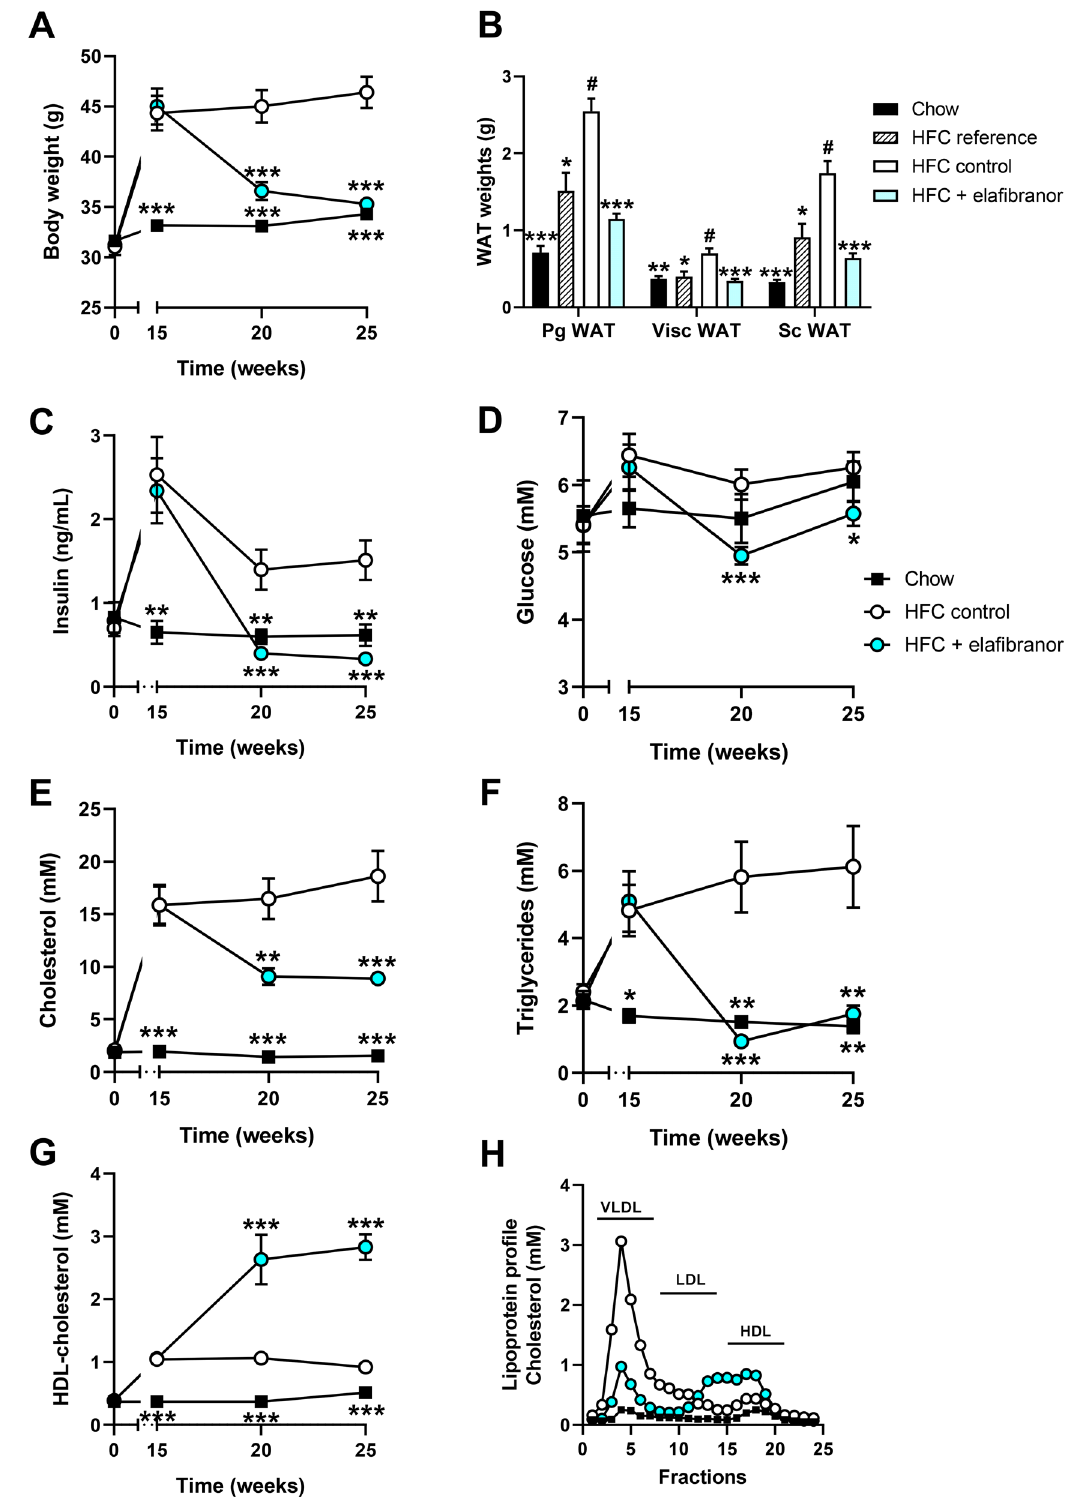
Figure 1. Metabolic parameters in E3L.CETP mice improved by elafibranor. Body weight ( A ), WAT weight of different adipose tissue depots ( B ), plasma insulin ( C ), blood glucose ( D ), plasma cholesterol ( E ), plasma triglycerides ( F ), plasma HDL-cholesterol ( G ), lipoprotein profiles in plasma samples pooled per group ( H ), plasma ALT ( I ) and plasma AST ( J ) from E3L.CETP mice fed a healthy chow diet or fed a HFC diet for 15 weeks and left untreated or treated with 15 mg/kg/d elafibranor for 10 weeks. Values represent mean ± SEM for n = 8 chow mice, n = 6 HFC reference mice and n = 15 HFC control or HFC + elafibranor treated mice. * p < 0.05, ** p < 0.01 and *** p < 0.001 vs. HFC control; # p < 0.05 vs. HFC